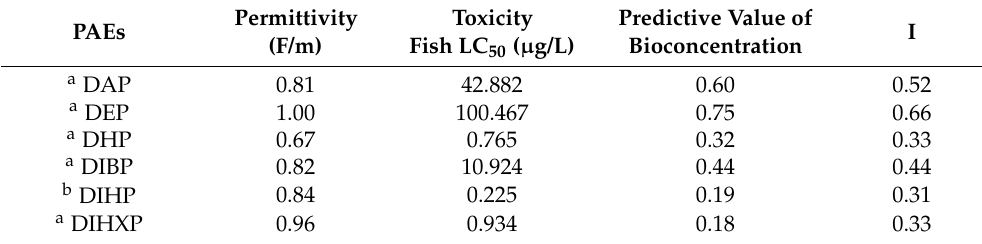
Table 2. Comprehensive effect value (I) of PAEs’ molecular insulation, toxicity, and bioconcentration. Permittivity PAEs